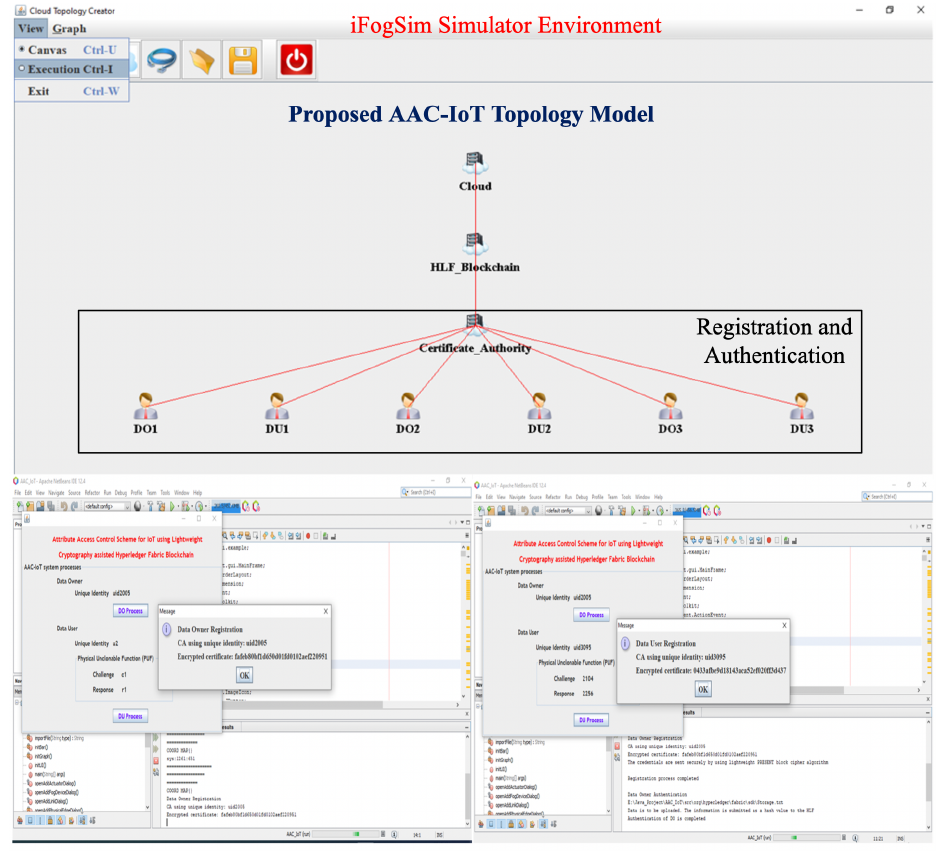
Figure 8. The AAC-IoT implementation